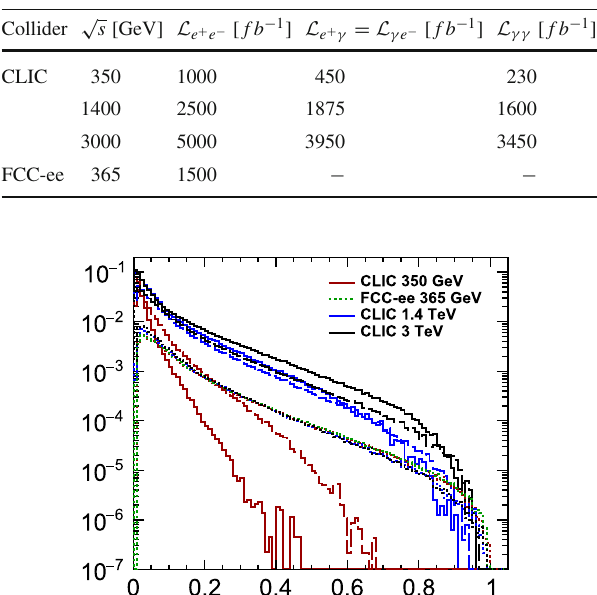
Table 1 Assumed integrated luminosities for e + e − , e ± γ and γγ colli- sions at CLIC and FCC-ee, where the photons originate from the Beam- strahlung effect